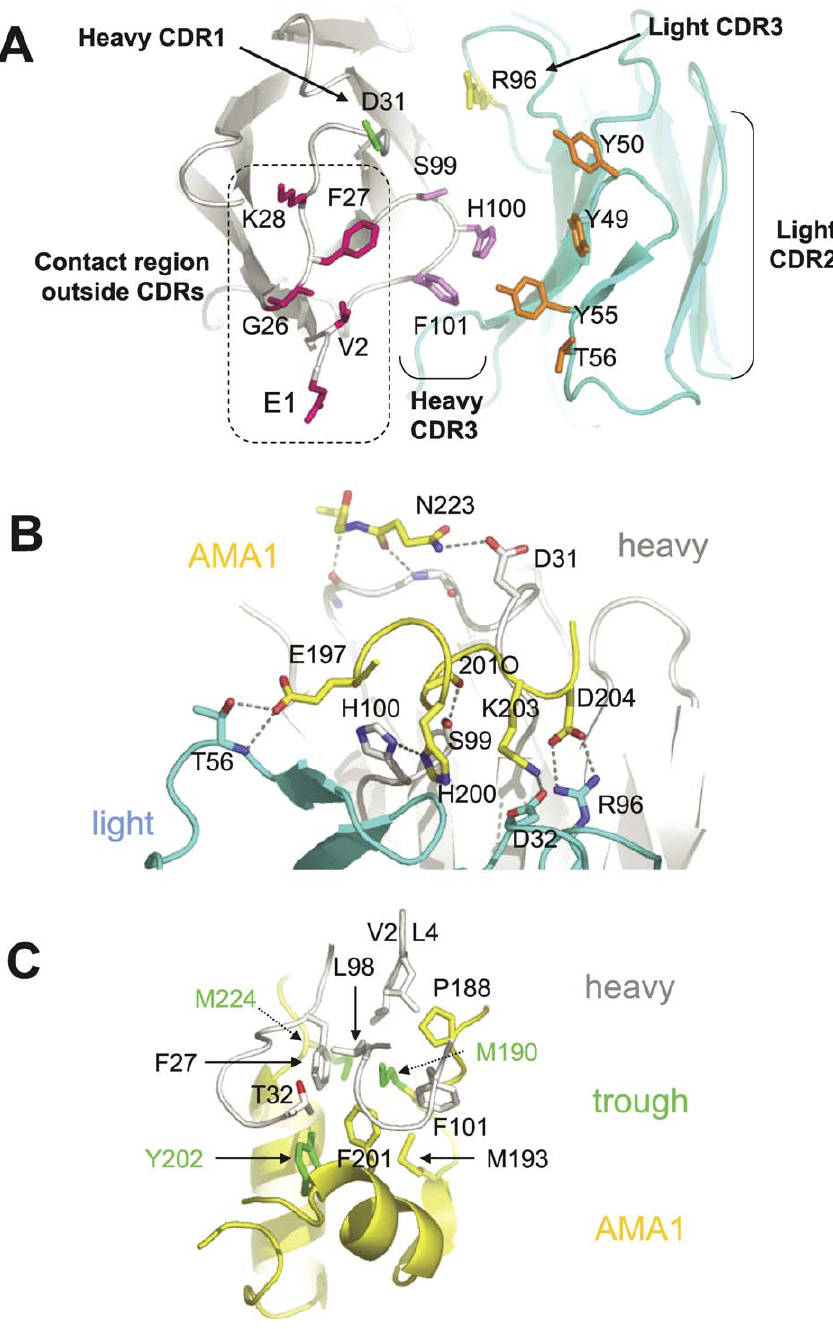
Figure 4. 1F9 Recognition Surface and Details of the 1F9–AMA1 Interaction In all panels AMA1 main chain is coloured yellow, 1F9 light chain is light blue, and 1F9 heavy chain is grey/white. (A) View of the CDR loops on 1F9. Residues shown are those with an AMA1 contact surface area of at least 35 A˚ 2 . Light chain CDR2 and 3 side chains are coloured orange and yellow, respectively, with heavy chain CDR 1 and 3 side chains coloured green and violet, repectively. Residues coloured pink are in the antibody framework region. Amino acid numbering refers to the 1F9 sequence. In the Kabat numbering scheme [57] heavy chain residue S99 is S95, H100 is H96, and F101 is F102. Light chain numbering is the same as in the Kabat numbering scheme. (B) Principal hydrogen bond interactions between AMA1 and 1F9. Side view of the AMA1-1F9 interface showing that most hydrogen bond interactions occur between AMA1 loop Id (residues 197–204), 1F9 light chain residues and the heavy chain CDR3 (residues S99 and H100). 201O is the main-chain carbonyl oxygen of residue 201. (C) View of the 1F9 heavy chain hydrophobic residues sitting in the hydrophobic trough. Hydrophobic trough side chains are coloured green.